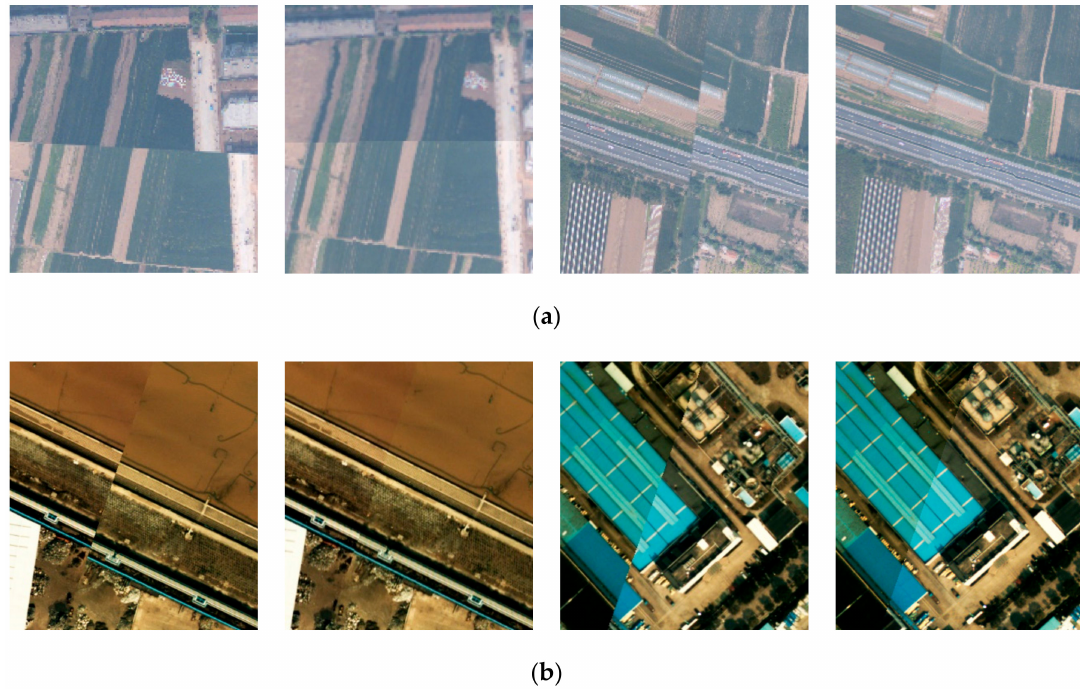
Figure 12. Local area of georeferenced images before and after boresight misalignments calibration: ( a ) Dataset 1; and ( b ) Dataset 2.